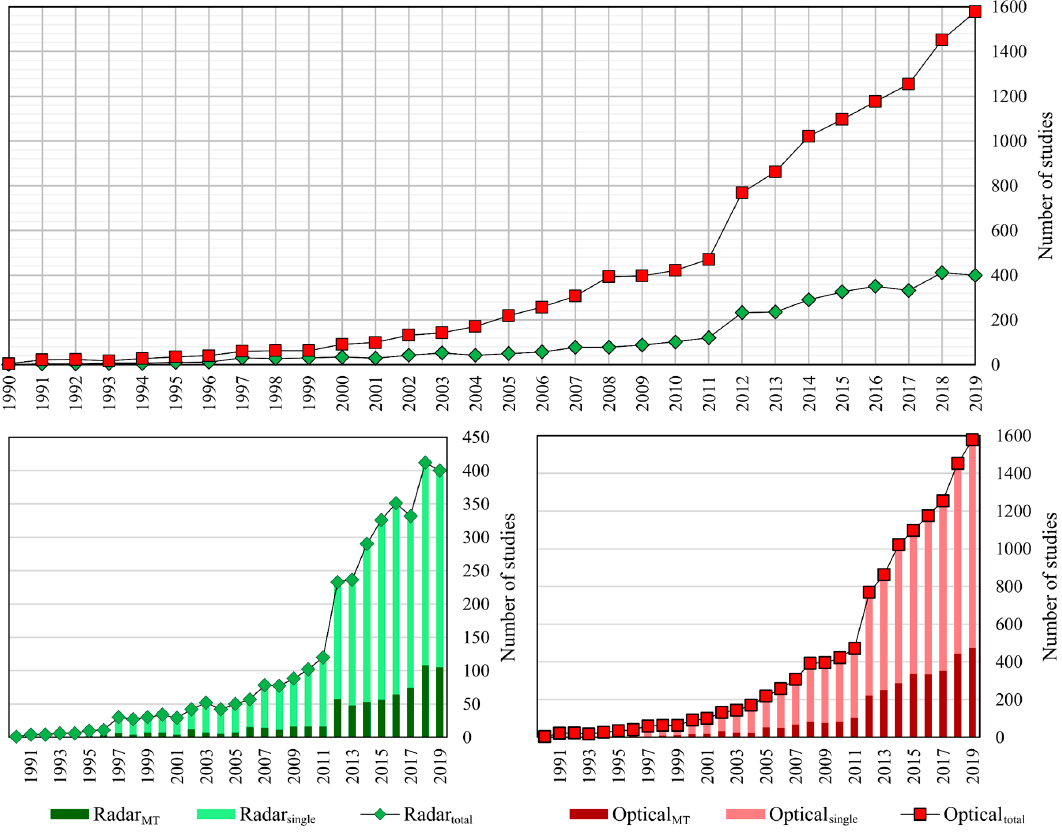
Figure 1. The number of published articles (1990–2019) listed in the Web of Science Core Collection containing the terms/topic “radar” or “scatteromet*” or “microwave*” or “SAR” for radar, and “optic*” or “Landsat” or “Sentinel-2” or “Sentinel-3” or “Quickbird” or “MODIS” or “IKONOS” or “GeoEye” or “WorldView” for optical imagery, refined by “land cover” or “land use”. To extract a number of multitemporal related articles, the final results were refined by “multitemporal” or “multi-temporal” or “multi temporal” or “time-series” or “time series”.